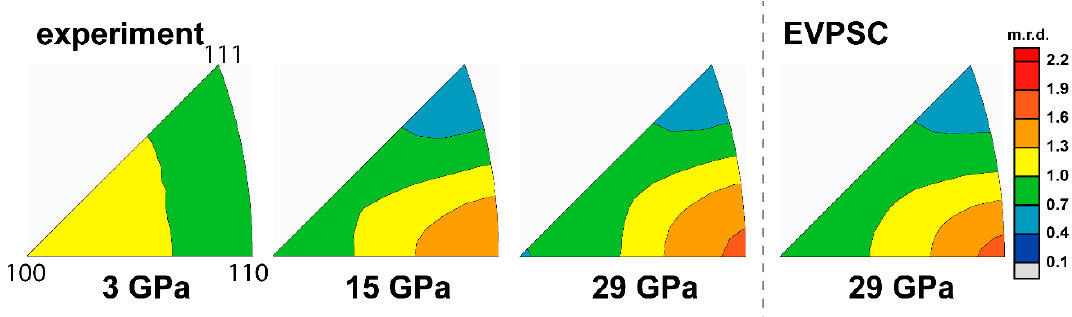
Figure 2. ( a ) Experimental and modeled Q-factors of pure NaCl; ( b ) slip system activity.